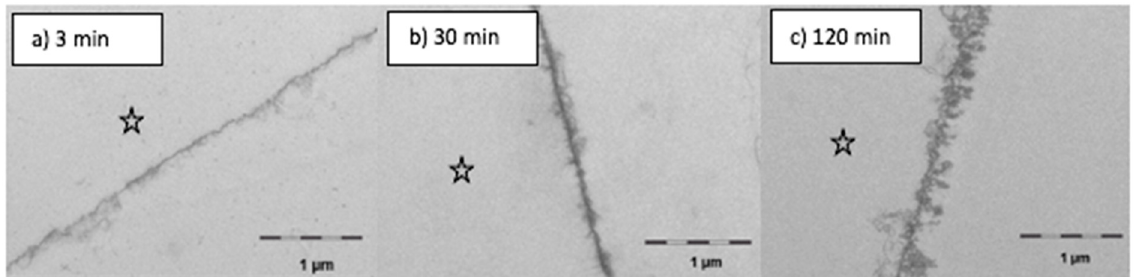
Figure 6. Transmission electron microscopy—control samples. The 3 min pellicle has a continuous electron dense basal layer with few granular structures ( a ). After longer oral exposure for 30 min ( b ) or 120 min ( c ) more granular and globular structures adsorb to the pellicle layer. The enamel was removed during the preparation of the samples; the former enamel side is marked with an asterisk.